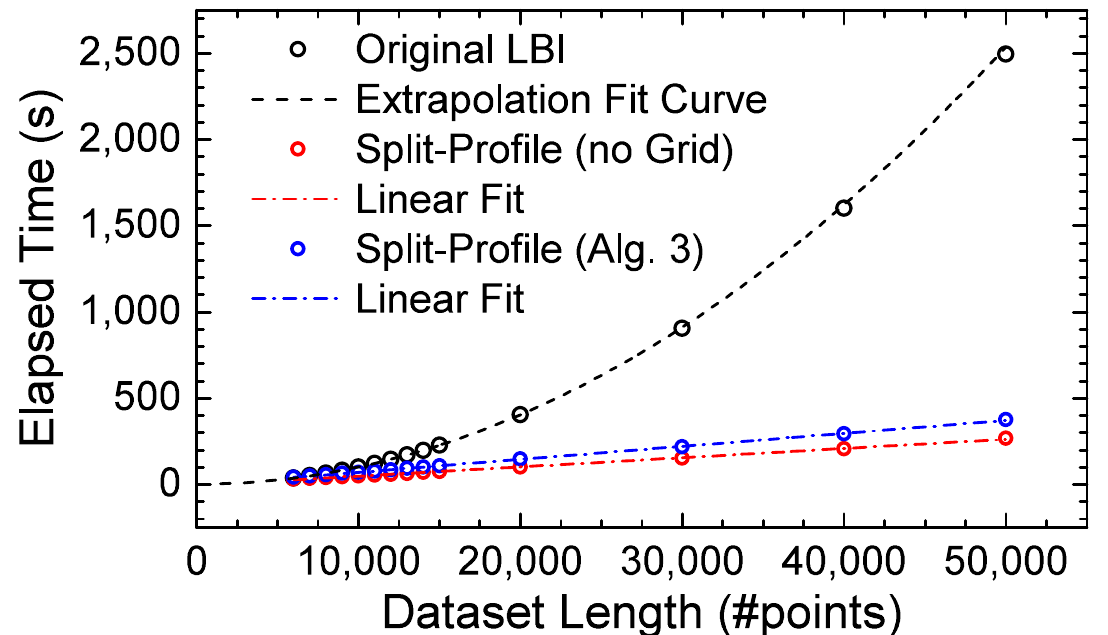
Figure 5. Final timing comparison between the original LBI and the corresponding split-profile LBI; two versions of the latter, with and without the λ -grid, are depicted. For shorter dataset lengths, the effect of the split-profile methodology is rather negligible since the original length is comparable to the individual split-profile length; however, as the dataset length increases above 20,000 points, a very clear distinction can be observed between the total elapsed times of the variants of the analysis